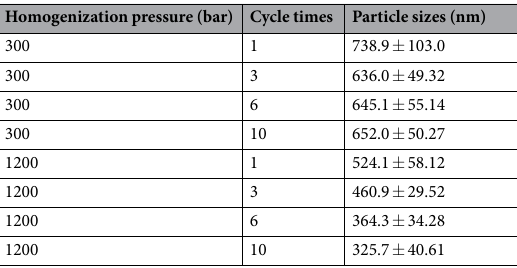
Homogenization pressure (bar) Cycle times Particle sizes (nm)